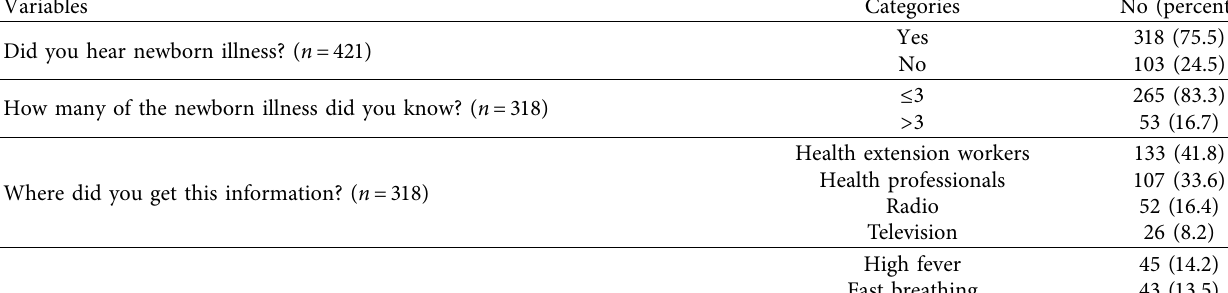
Table 4: Knowledge level of mothers regarding NBDS in Anlemo district, southern Ethiopia, 2019.